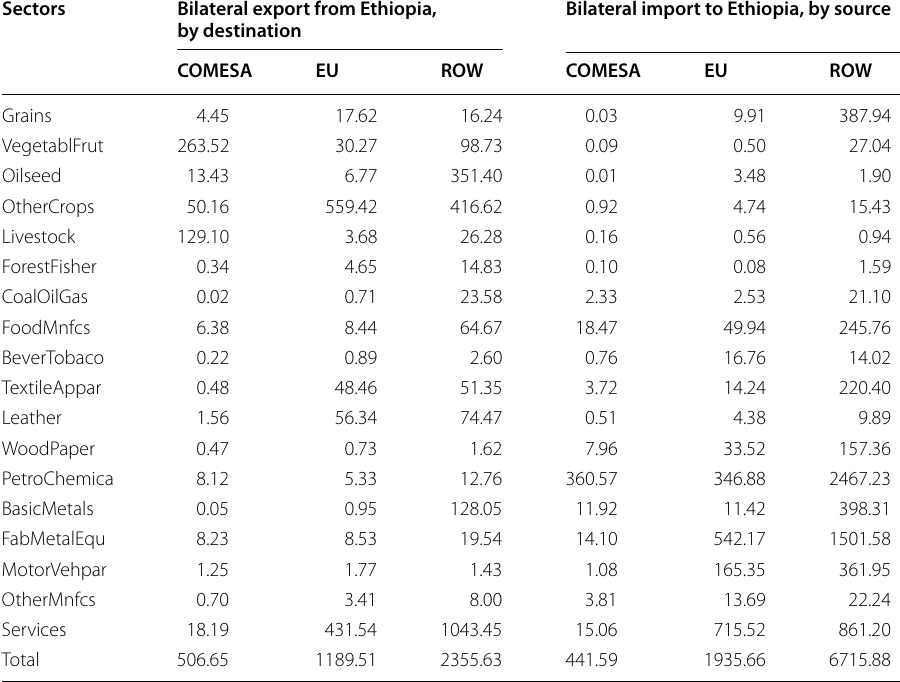
Table 4 Bilateral export and import for Ethiopia, by aggregated sectors (US$